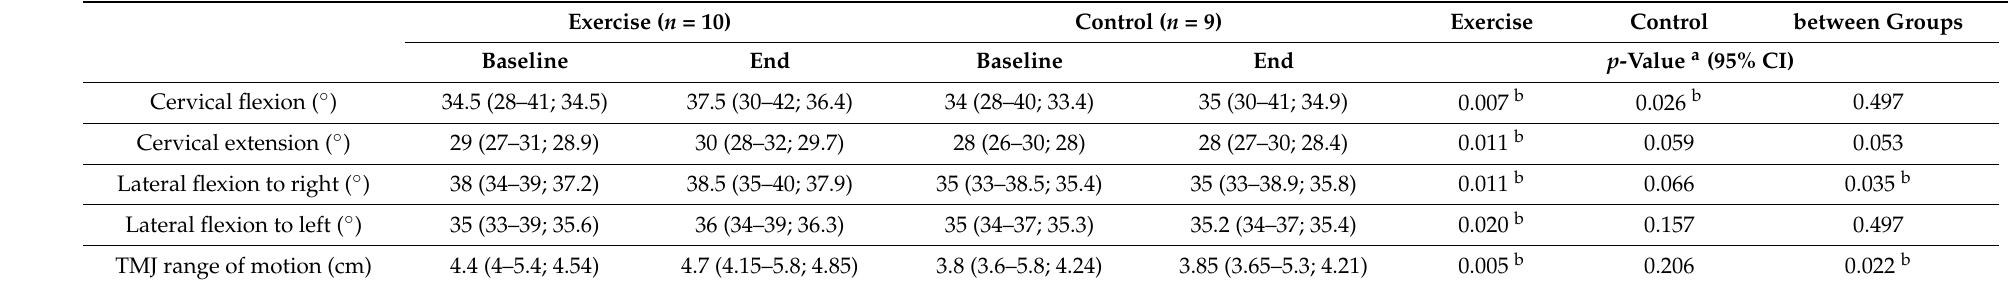
Table 2. Results of cervical range of motion in groups.